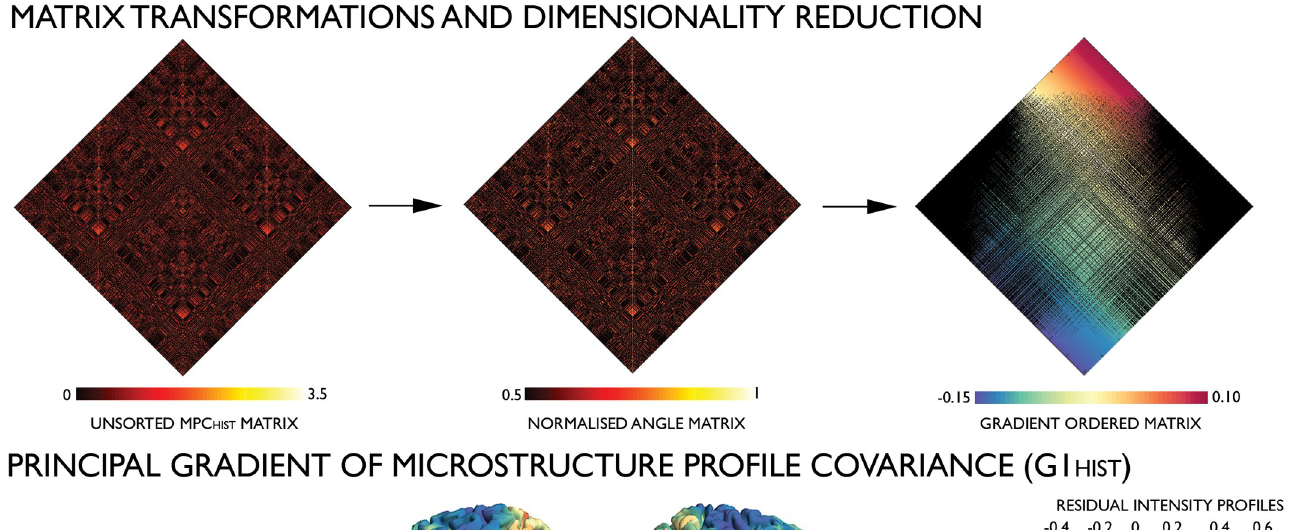
cytoarchitectural taxonomy each accounted for 17% of variance in G1